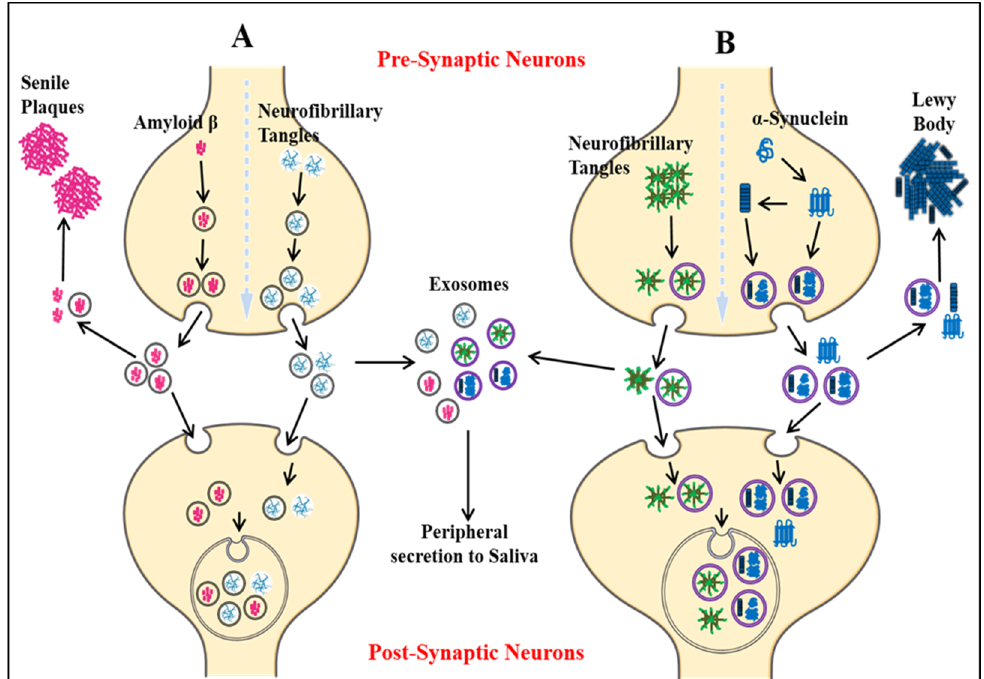
Figure 5. Seeding of hallmark proteins in a prion-based manner by exosomes ( A ) the seeding of amyloid-beta and tau protein through exosomal cargo in Alzheimer’s disease (AD), dispersion of AD pathology. ( B ) the seeding of alpha-synuclein and tau protein in Parkinson’s disease (PD) through exosomal cargo, dispersion of PD pathology. The presence of all these prime proteins in the biofluid saliva after the exosomes cross the blood–brain barrier (BBB).